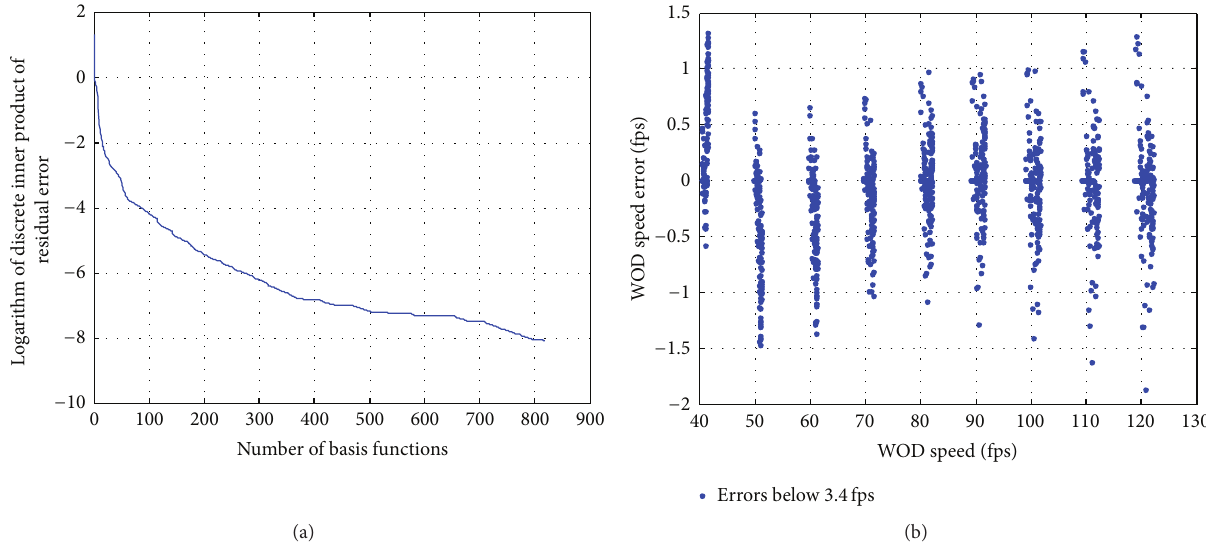
Figure 9: (a) Logarithm of discrete inner product norm of residual error. (b) Wind speed prediction errors on the RALS tower data when training was conducted on data at every 4-degree increments of yaw